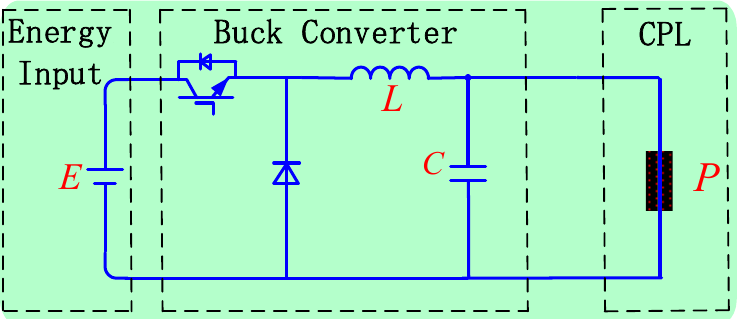
Figure 1. A simplified model of a DC microgrid.